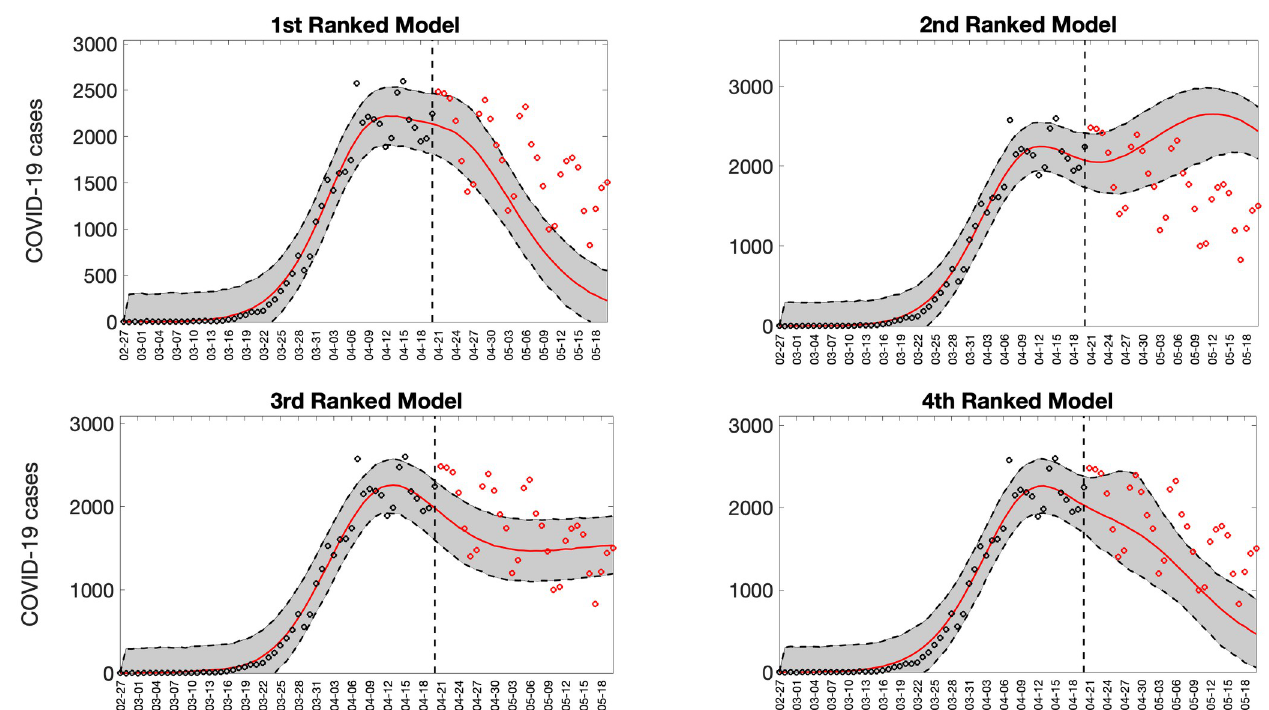
Fig 6. Representative 30-day forecasts of the top-ranking sub-epidemic models to the daily curve of COVID-19 deaths in the USA from 20-April-2020 to 20-May-2020. The model fit (solid line) and 95% prediction interval (shaded area) are also shown. The vertical line indicates the start time of the forecast. Circles correspond to the data points. These four top-ranking models support forecasts with diverging trajectories even though they yield similar fits to the calibration period. For instance, the 1 st ranked sub-epidemic model predicts a decline in the mortality curve, whereas the 2 nd ranked model predicts a stable pattern during the next 30